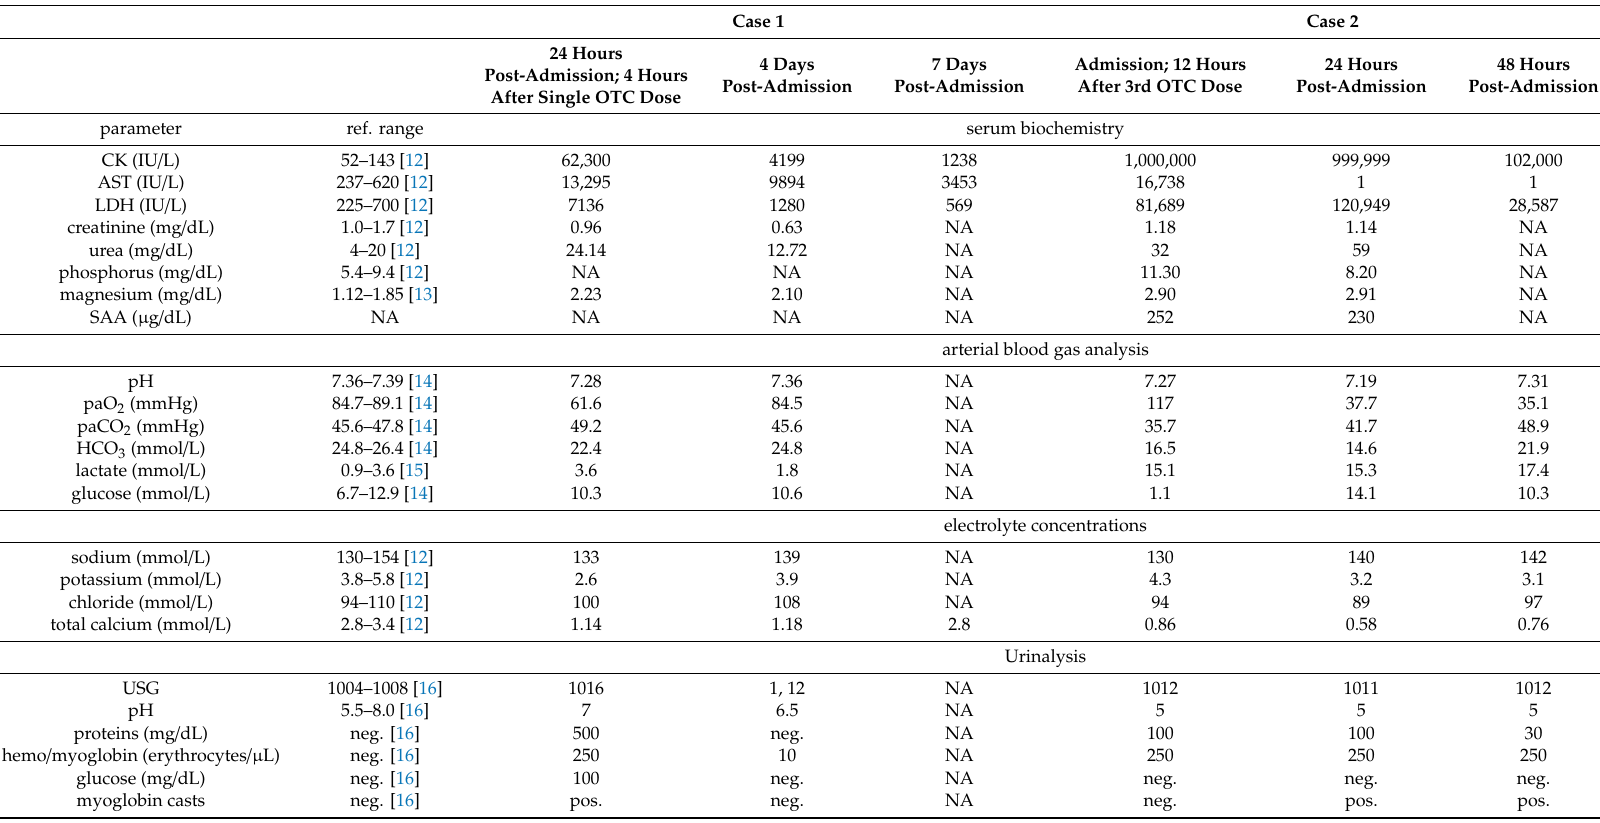
Table 1. Summary of alterations observed in the presented cases for serum biochemistry, arterial blood gas analysis, electrolyte concentrations and